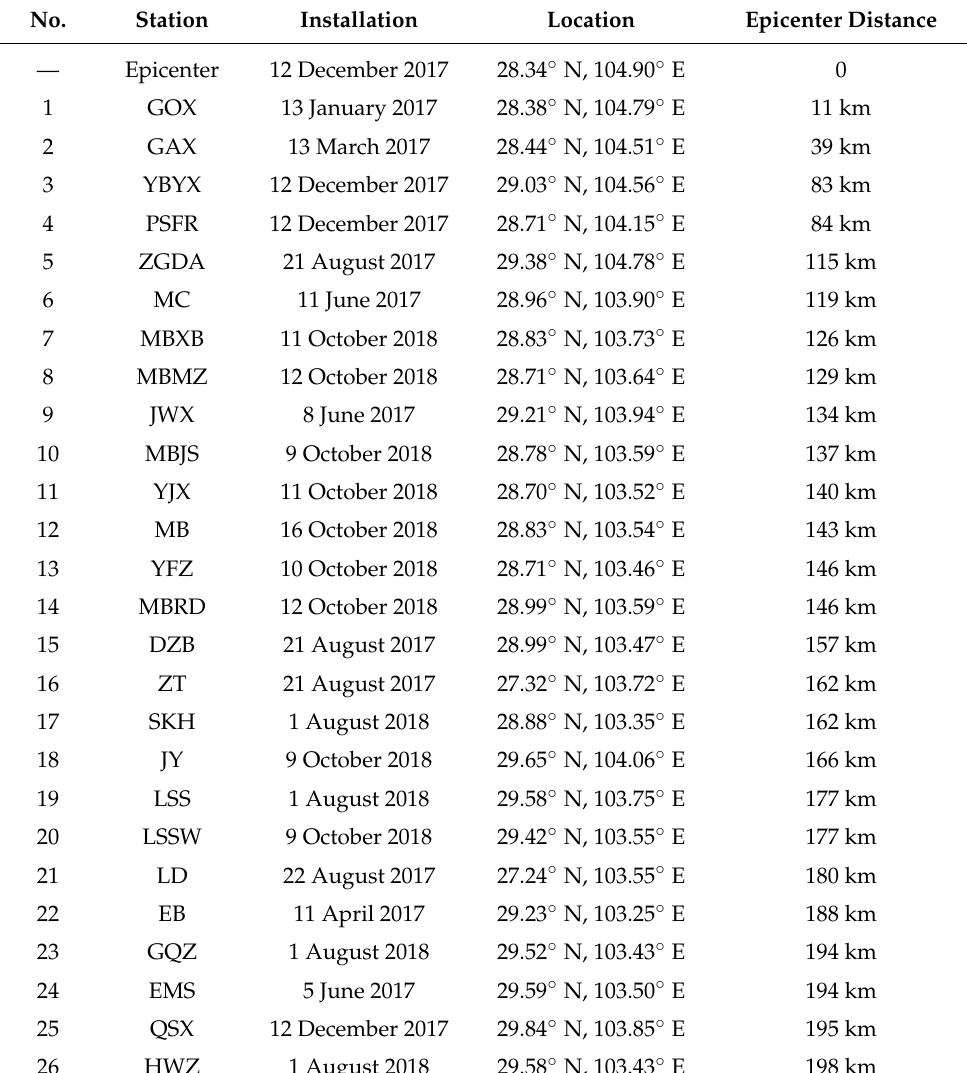
Table 3. AETA Station within 200 km of the Yibin